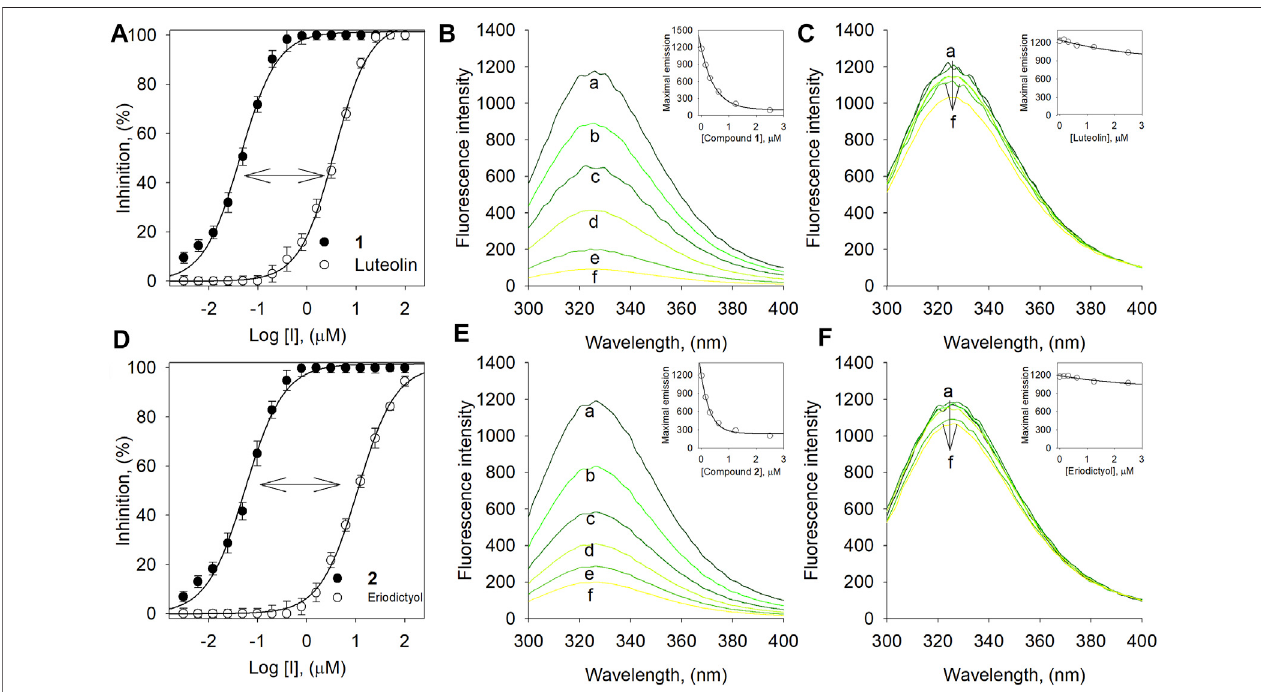
FIGURE4|(A) Dose-dependentinhibitioneffectofcompound 1 vs .luteolinonBNA. (B) The fl uorescenceemissionspectraofBNAatdifferentconcentrationsof 1 and (C) luteolin. (D) Dose-dependentinhibitioneffectofcompound 2 vs .eriodictyol onBNA. (E) The fl uorescenceemissionspectraofBNAatdifferentconcentrationsof 2 and (F) eriodictyol (0, 0.16, 0.31, 0.63, 1.25, and 2.5 μ M for curves a → f).